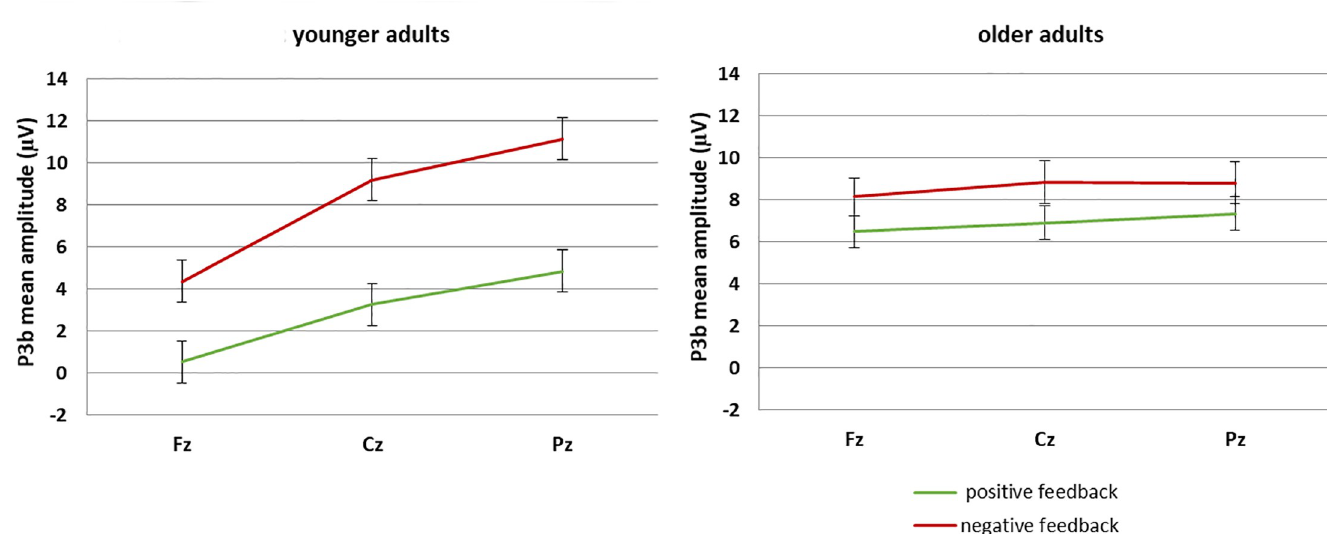
Fig 4. Illustration of the interaction between feedback valence and anterior/posterior in younger adults’ P3b mean amplitudes (whiskers denote standard errors of the mean). This effect was absent in the older adults’ P3b